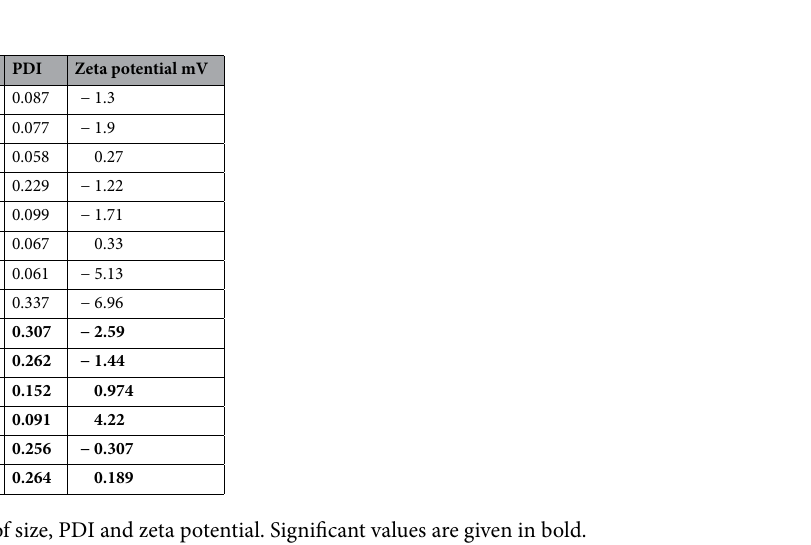
Table 4. Results of size, PDI and zeta potential. Significant values are given in